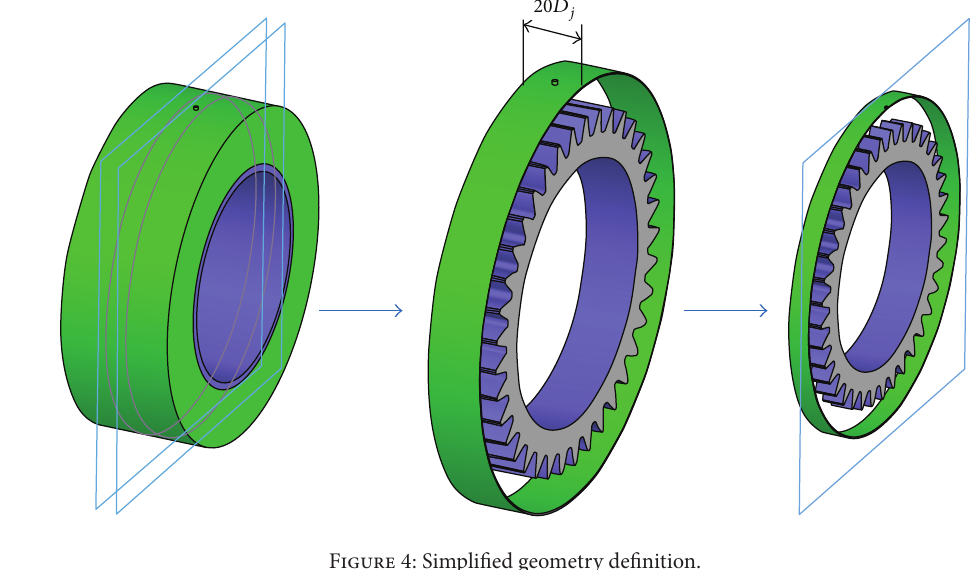
Figure 4: Simplified geometry definition.